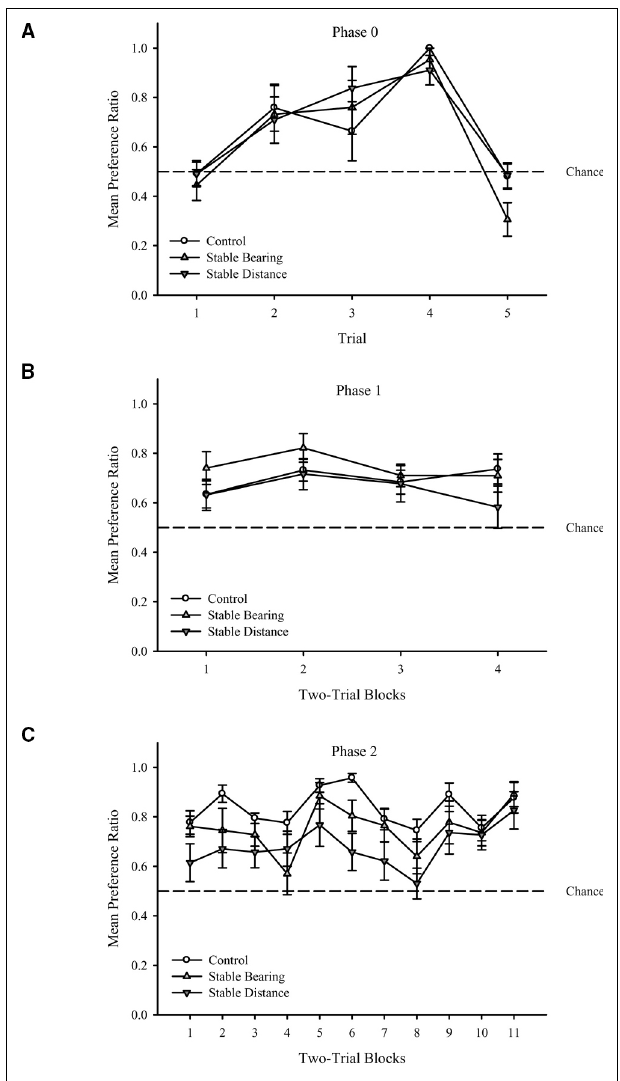
FIGURE 3 | (A) Mean preference ratio during Phase 0 (A) , Phase 1 (B) , and Phase 2 (C) training trials for each group. Dashed lines represent chance performance (0.5). Error bars represent standard errors of the